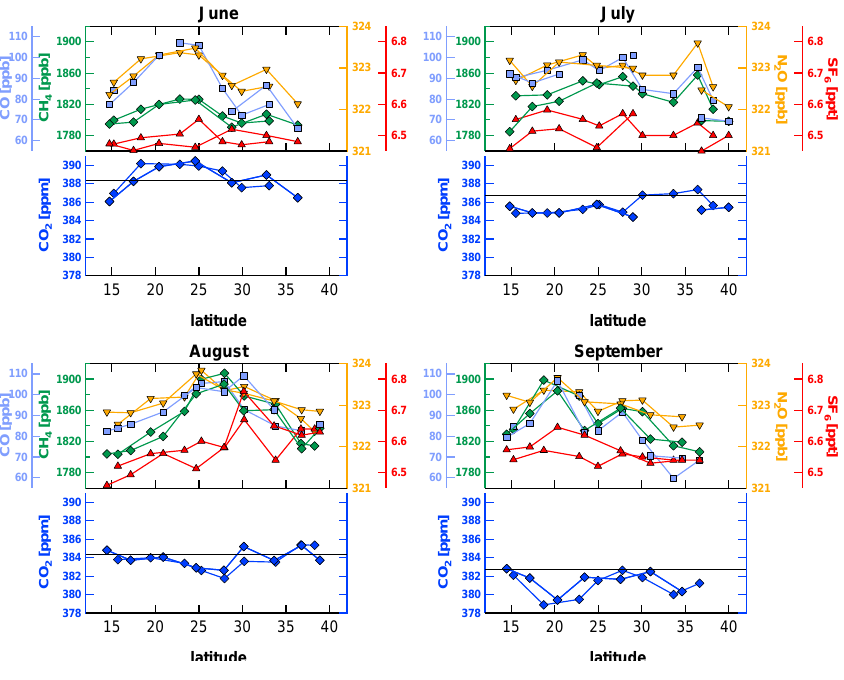
Fig. 5. Latitudinal distributions of CH 4 , CO 2 , N 2 O, and SF 6 from air samples and on-line measured CO mixing ratios integrated over the Figure 5: Latitudinal distributions of CH sampling period for flights between Frankfurt and Chennai in June, July, August, and September 2008. For CO 2 the mean mixing ratio on-line measured CO mixing ratios integrated over the sampling period for flights be- observed at Mauna Loa Observatory (19 ◦ N) is indicated by a solid tween Frankfurt and Chennai in June, July, August, and September 2008. For CO the mean mixing ratio observed at Mauna Loa Observatory (19 ◦ N) is indicated by a solid line.